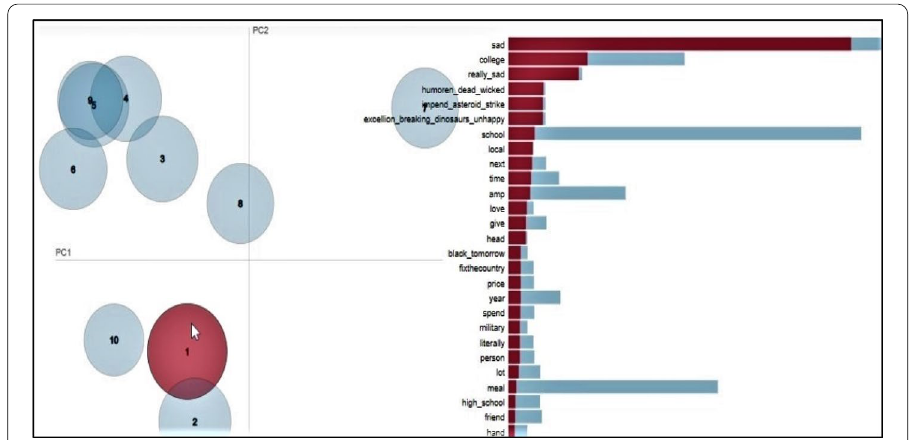
Fig. 12 Topic 1’s most frequent words (marked in red)